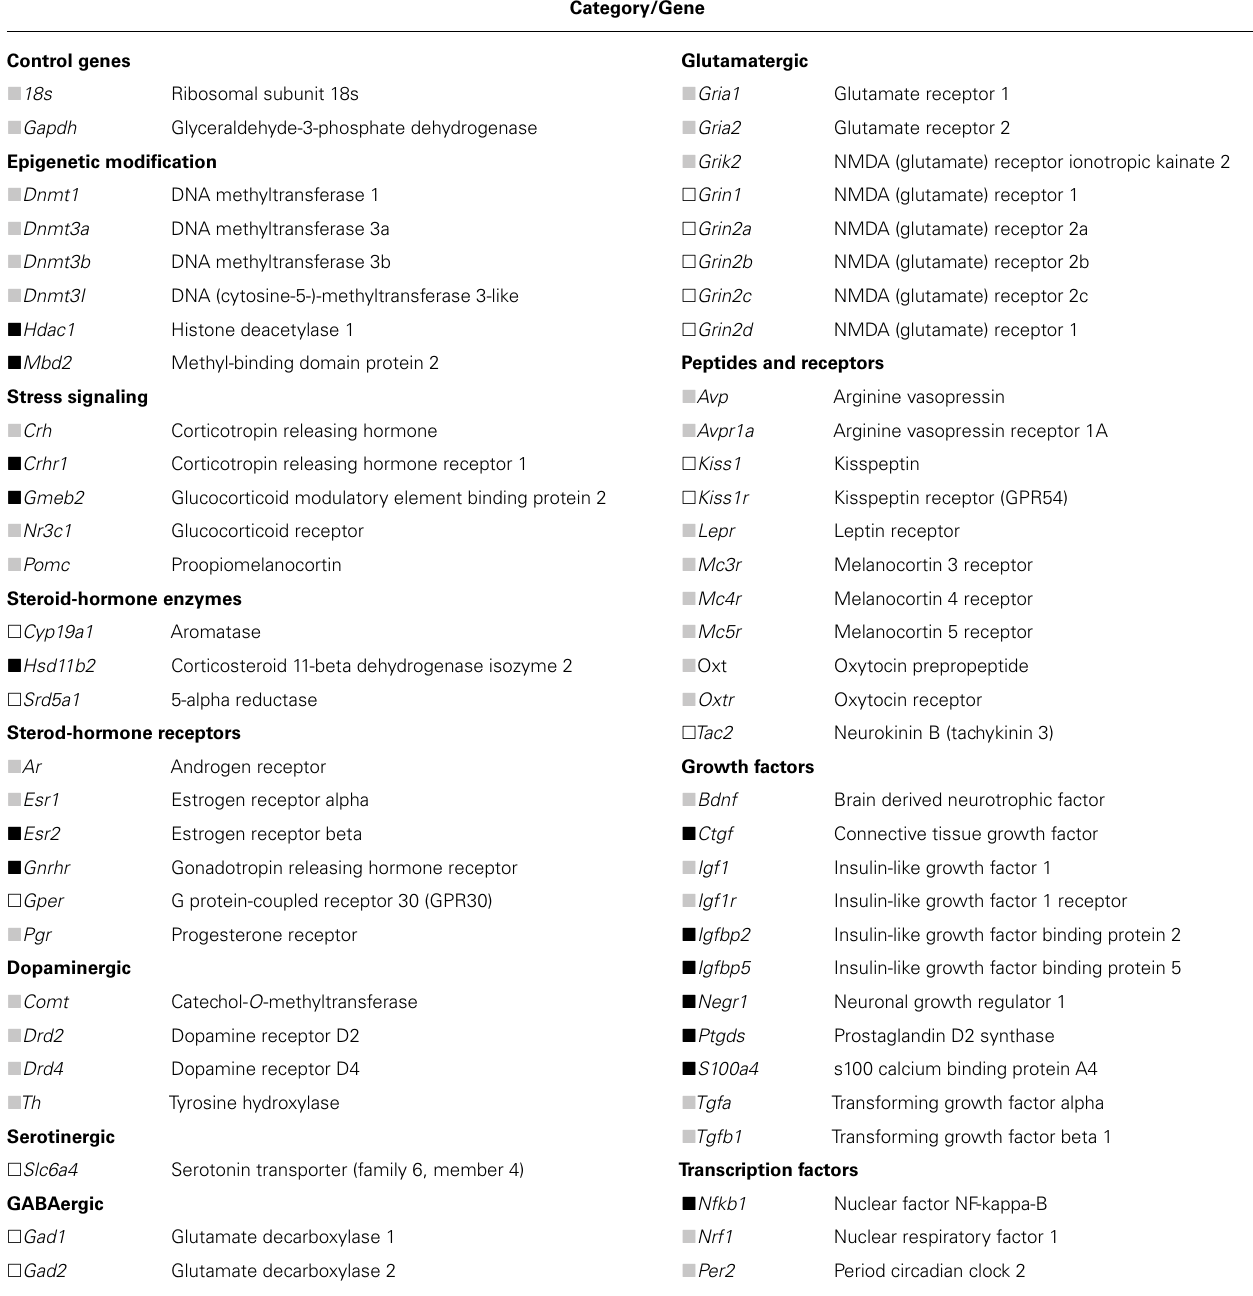
Table 1 | Gene abbreviations and names.